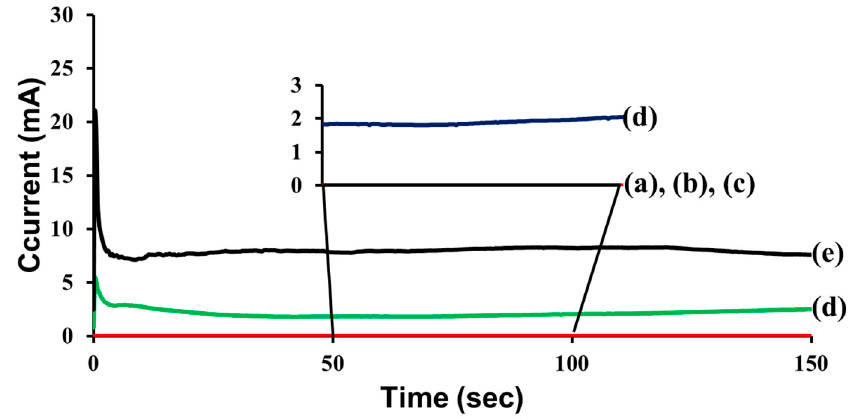
Figure 5. Current versus time for scratched self-healing and control coatings: ( a ) STP/DD-based coating before vibration; ( b ) MTP-based coating before vibration; ( c ) STP/DD-based coating after vibration; ( d ) MTP-based coating after vibration; and ( e ) control coating.